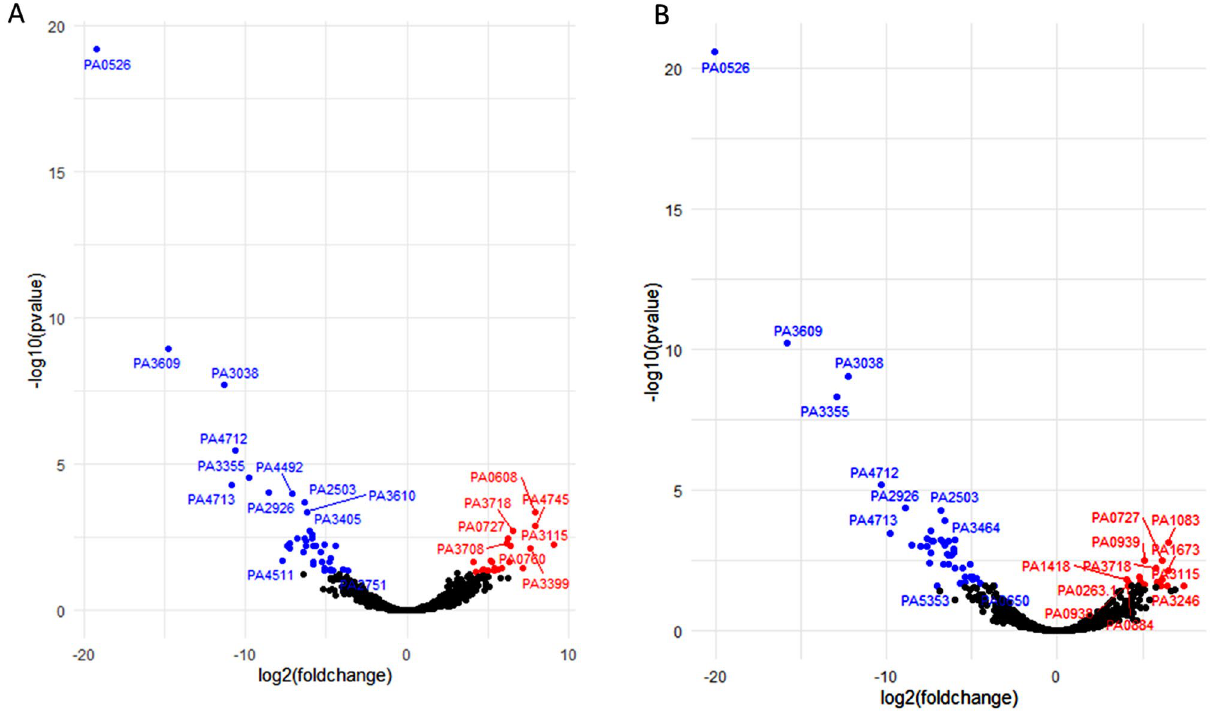
Figure 4. Volcano plots of DEGs. ( A ) Comparison of phoenix colony transcript counts to control lawn transcript counts showed 63 DEGs. ( B ) Comparison of VBNC-like colony transcript counts to control lawn transcript counts showed 90 DEGs. ( A , B ) Red dots indicate gene transcripts which were significantly upregulated (greater than twofold change and corrected p-value of 0.05 or less). Blue dots indicate gene transcripts which were significantly downregulated (greater than twofold change and corrected p-value of 0.05 or less). Black dots indicate genes with no-significant difference in